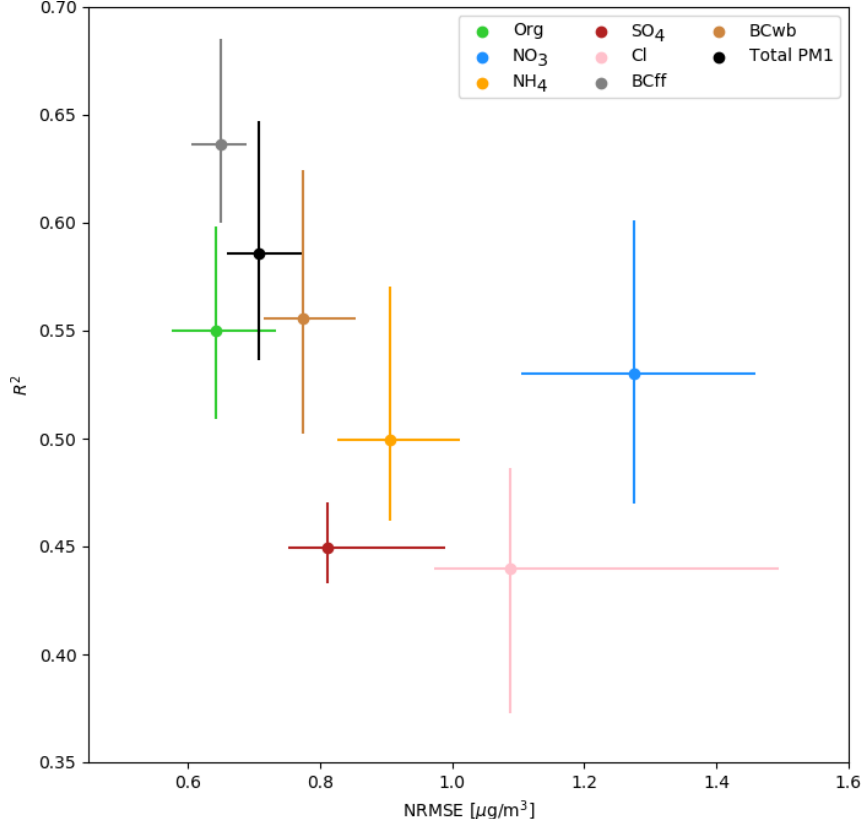
Figure 3. Performance indicators for 10 model iterations: coefficient of determination R 2 against normalized root mean squared error (NRMSE) for the separate species models (Org: organics, NH + carbon from fossil fuel combustion, and BCwb: black carbon from wood burning), and the total PM 1 model. Vertical and horizontal lines indicate the maximum spread in R 2 and NRMSE, respectively, between the 10 model